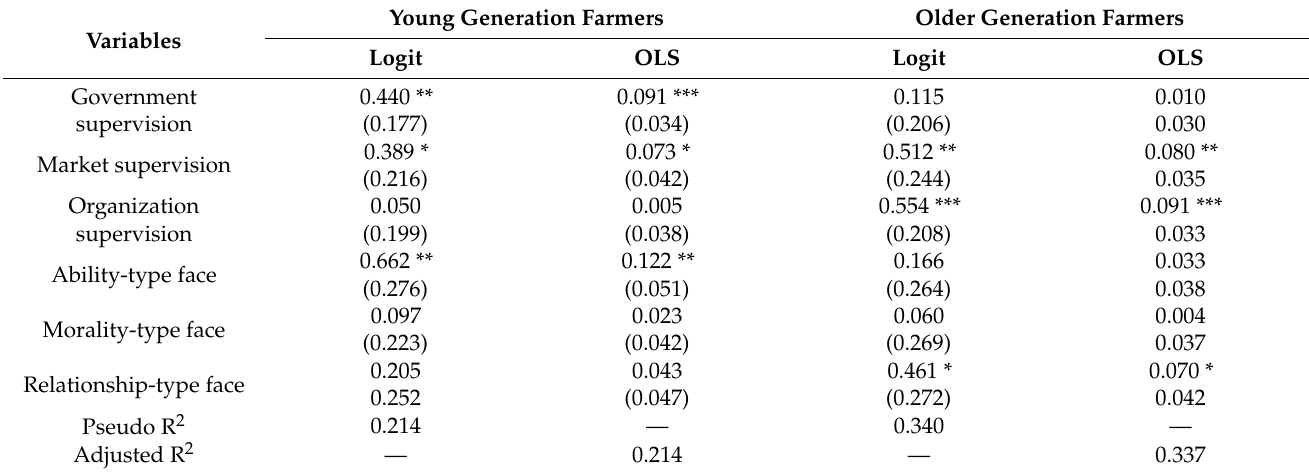
Table 7. Intergenerational differences in regression results for the effects of external supervision and face consciousness on pesticide safety